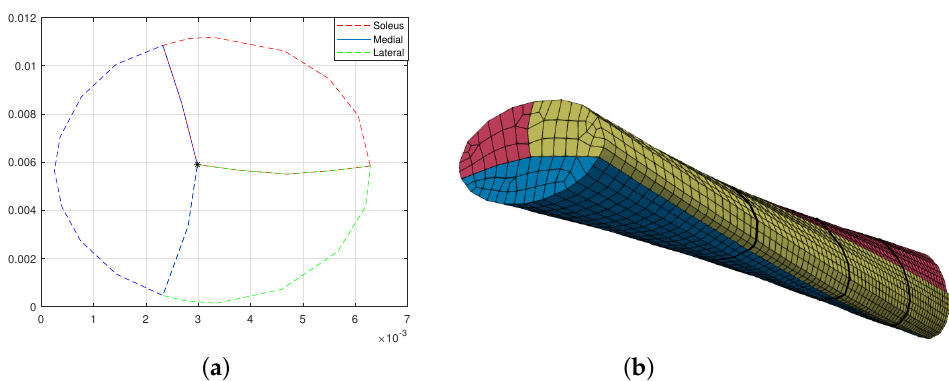
Figure 3. The Type III tendon representation . ( a ) The Achilles sub-tendons’ cross sections. ( b ) The pretwisted underformed Achilles tendon discretized by four ANCF-based continuum beam elements at each subtendon with ψ = 45 ◦ .